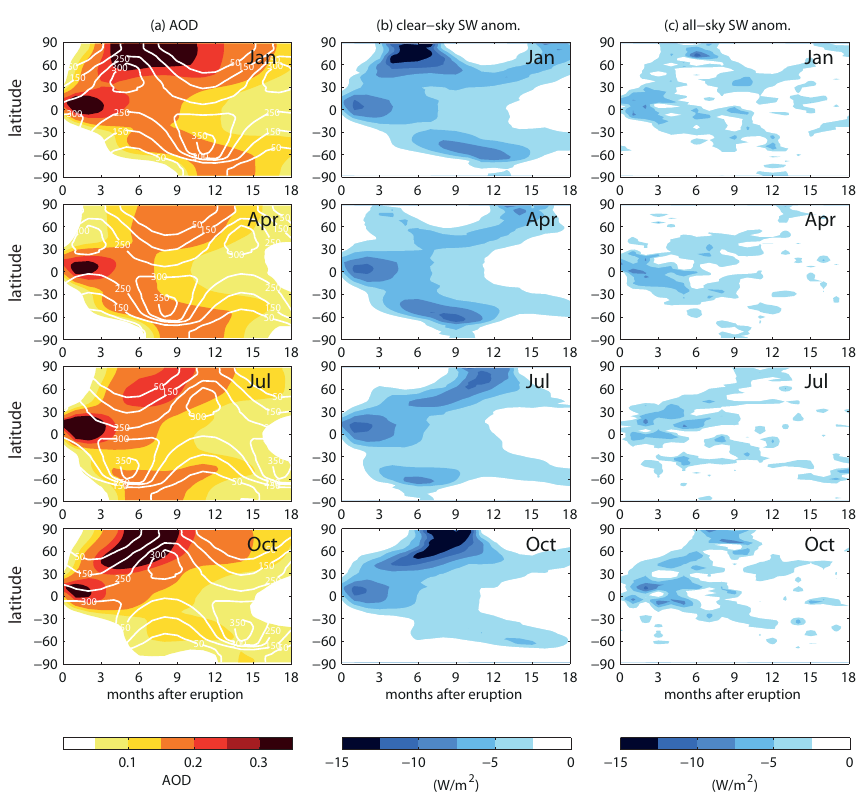
Fig. 3. Zonal mean, monthly mean 0.55µm aerosol optical depth (a) , clear-sky surface shortwave radiation anomalies (b) and all-sky surface shortwave anomalies (c) for E17 eruptions in January, April, July and October. White contours in column (a) show climatological surface clear-sky shortwave radiation: visual contrast between color shading and white contours is used to highlight climatological radiative flux at timing of large AOD. All anomalies shown are ensemble mean differences from a control run, and are significant at the 95% confidence